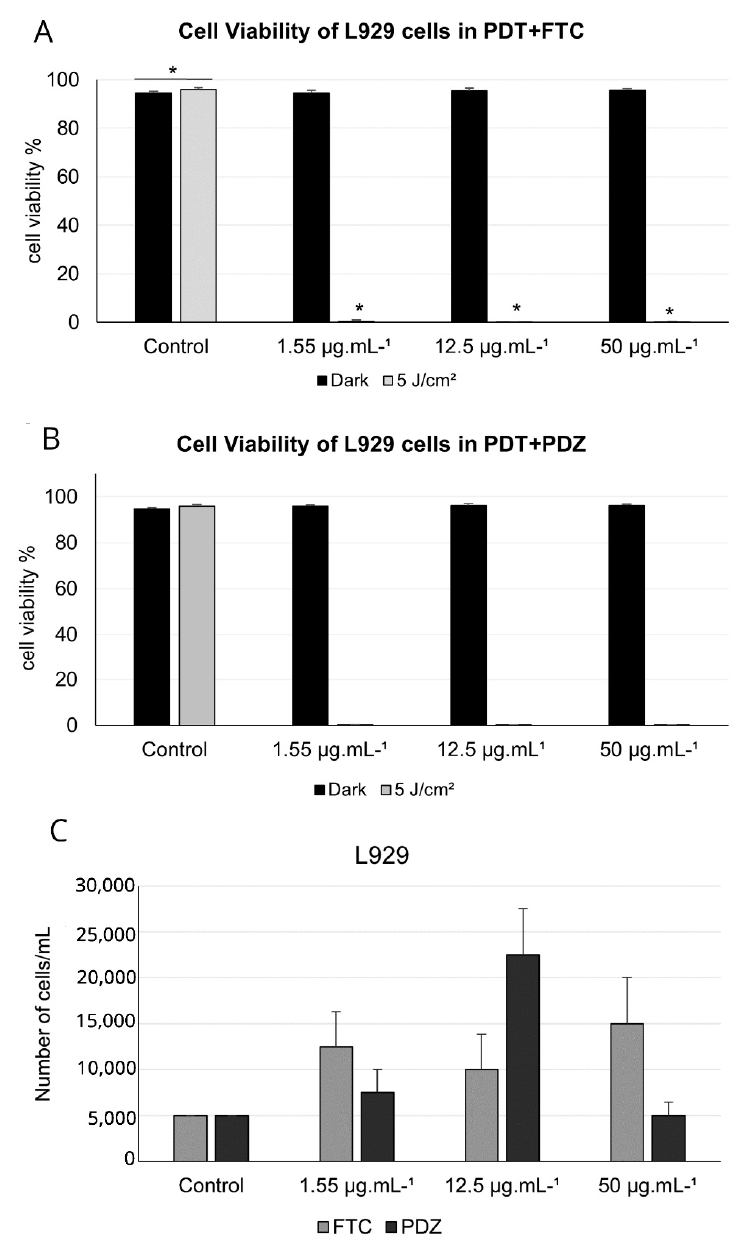
Figure 7. ( A )—Viability of the L929 cells in the supernatant 18 h after PDT with FTC, and control group irradiated at 5 J/cm 2 . ( B )—Viability of the cells in the supernatant 18 h after PDT with PDZ, and control group irradiated at 5 J/cm 2 . ( C )—Number of cells present in the supernatant 18 h after PDT application, at a fluence of 5 J/cm 2 , in L929 cells with FTC and PDZ, and control groups. Symbols for p < 0.01: *.